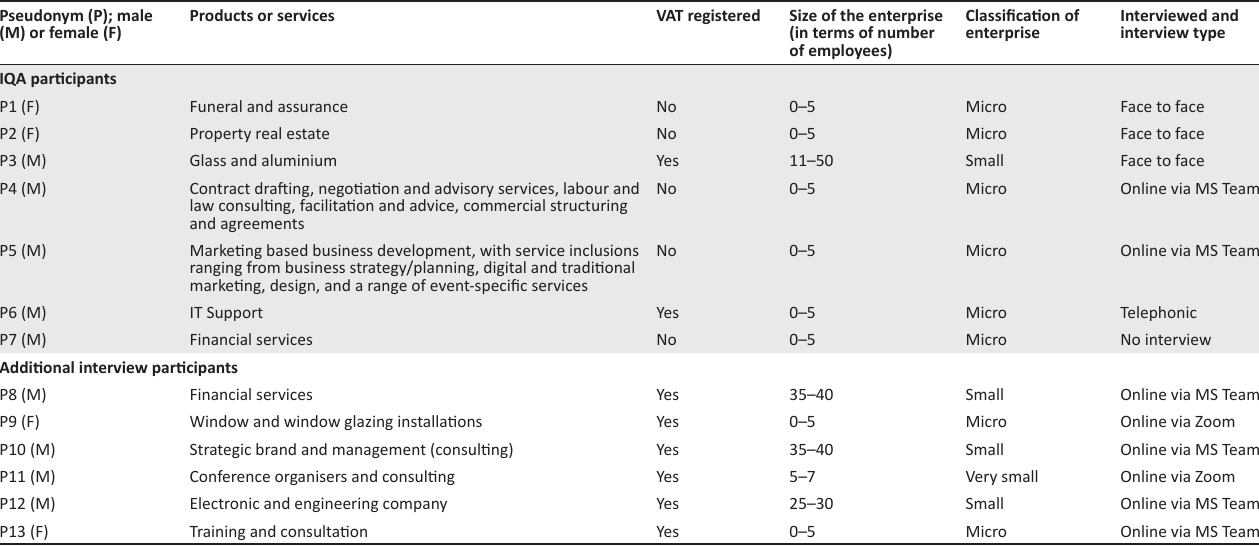
Table 1-A1: Participants’